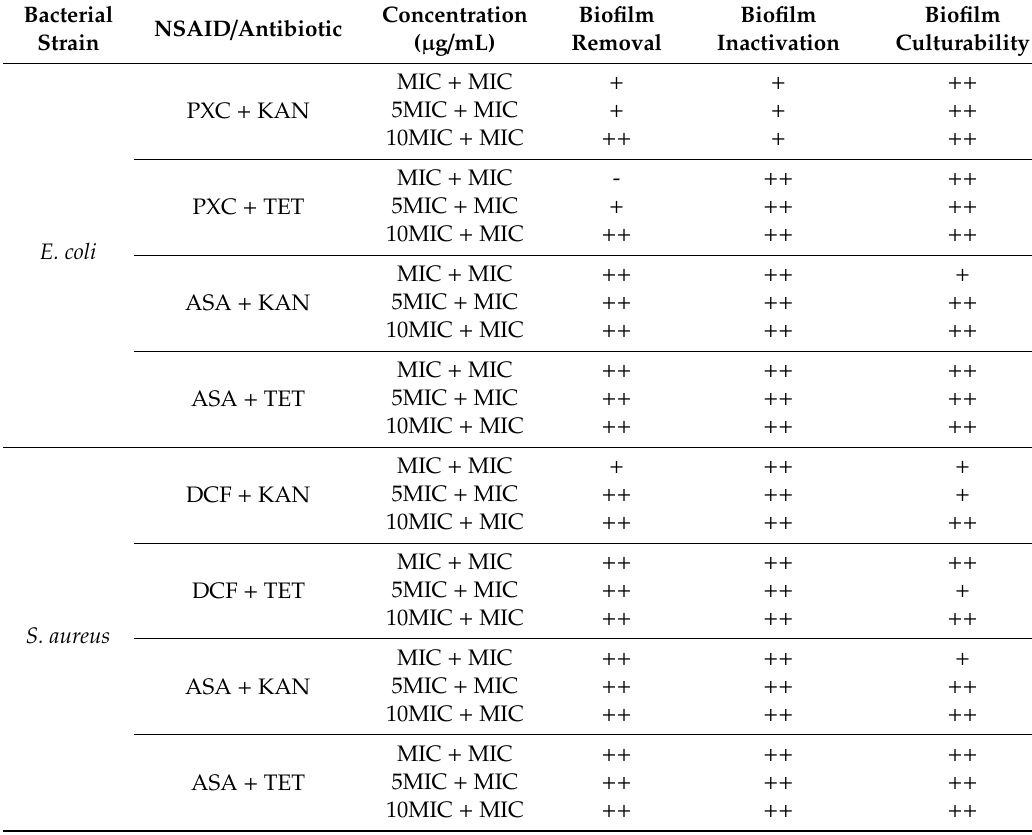
(cid:80) C I scoring of the selected NSAIDs (at MIC, 5 × MIC and 10 × MIC) with TET (tetracycline) Table 4. and KAN (kanamycin) (at MIC) in terms of biomass removal, biofilm inactivation and